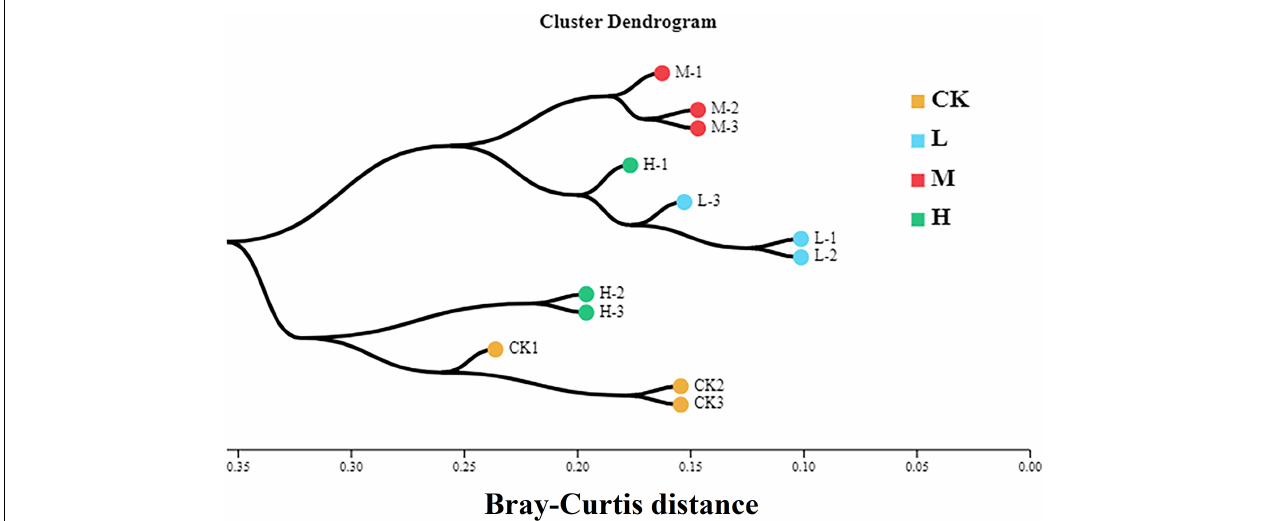
FIGURE 6 | Hierarchical cluster analysis of the four different nitrogen treatments. Different color indicates samples from each treatment. The branching length of each sample indicates Bray-Curtis distance. Samples closer to 0 indicate similarity, while closer to 1 indicate